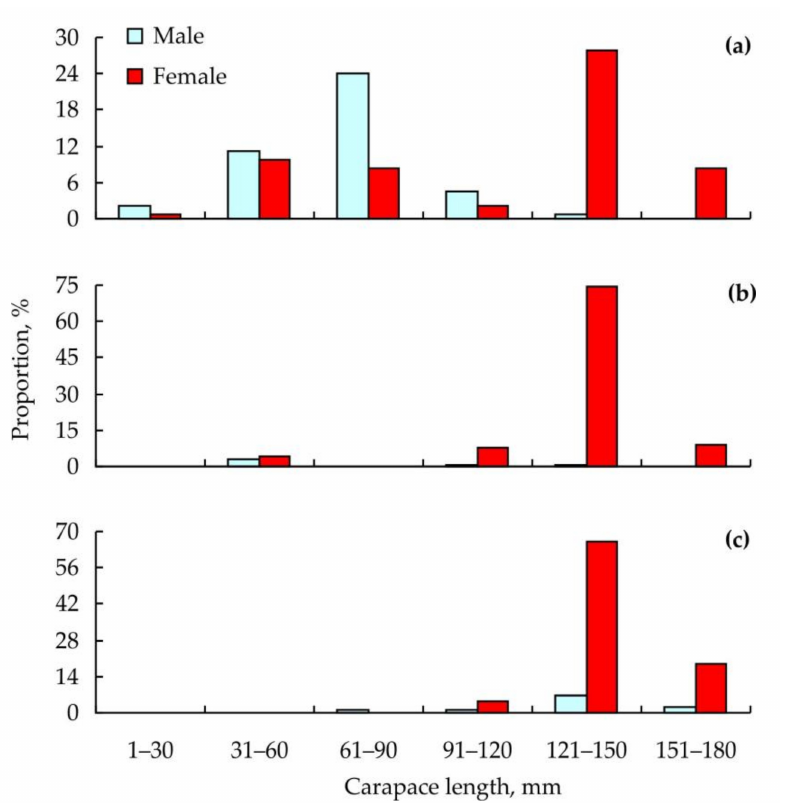
Figure 2. Size-frequency distributions of red king crabs collected for epibionts in Dalnezelenetskaya Bay in 2010 ( a ), 2018 ( b ), and 2019 ( c ).